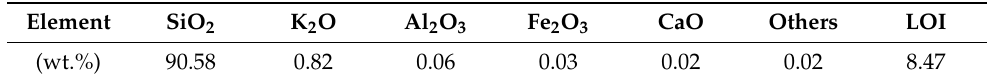
Table 2. Chemical composition of